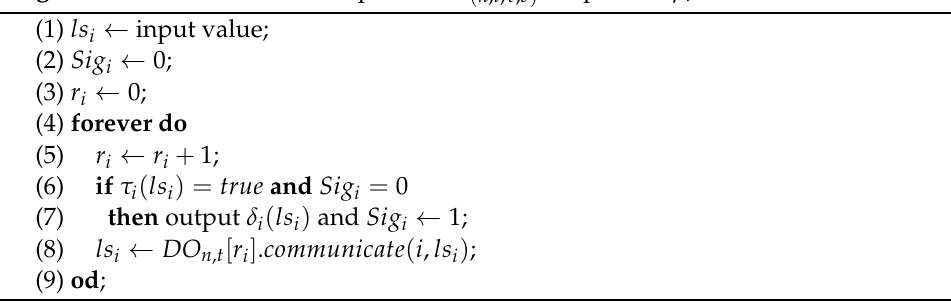
Algorithm 1: An execution of a protocol P (